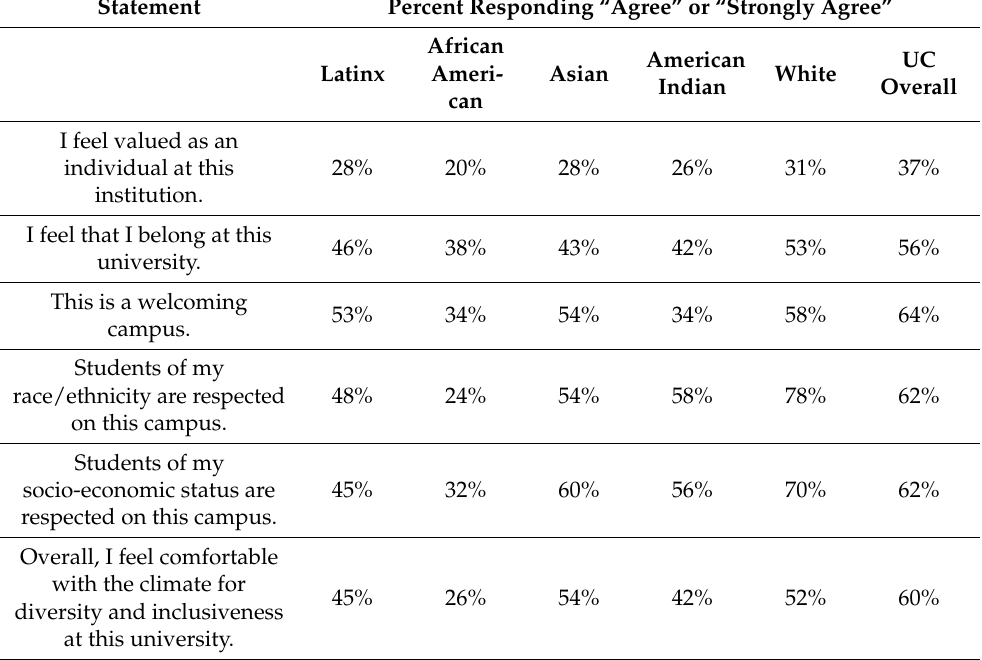
Table 2. Results of various Likert survey questions, by race/ethnicity, for the 2020 University of California Undergraduate Experience Survey (UCUES) at UCSC, compared to overall UC